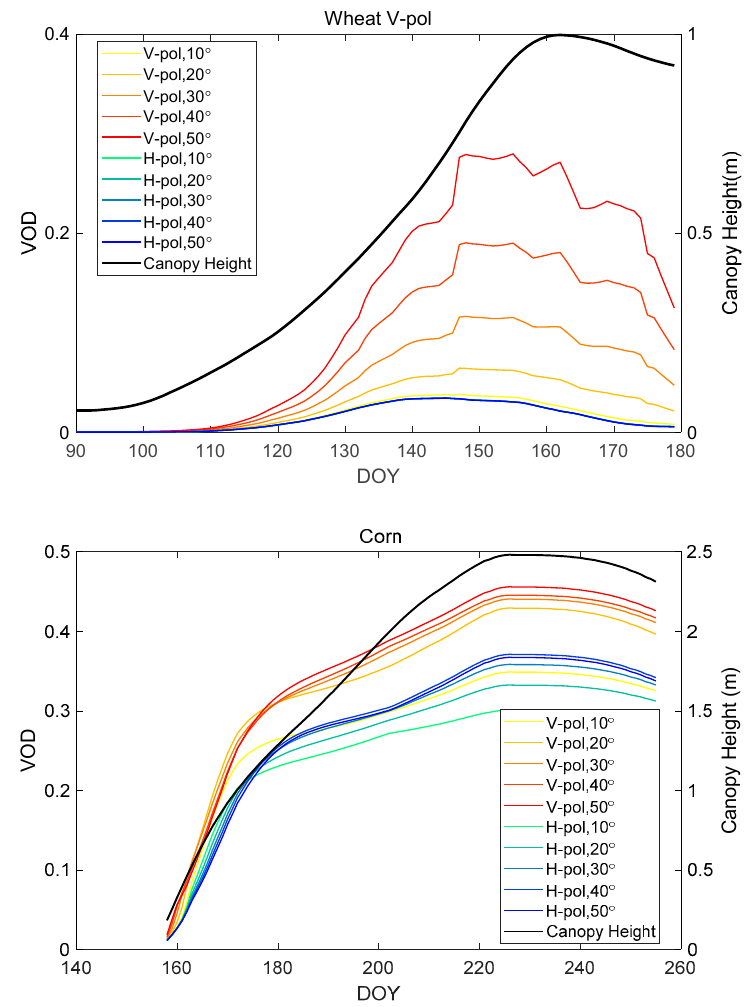
Figure 6. VOD S at V- and H-pol and several incident angles ( top : wheat, bottom : corn). To validate and explore the applicability of MVI to retrieve VOD, VOD T was calculated at the L-band and compared with VOD S , as shown in Figure 7. The correlation coefficients of VOD S and VOD T for corn and wheat were both as high as 0.99. But RMSE value of wheat figure was less than RMSE value of corn figure. The color bar shows the single leaf area of wheat and corn (cm 2 ). It is found that the retrieval accuracy decreases as leaf area increases, especially for corn. VOD T is underestimated comparing to VOD S for corn. It is believed that the assumption, the emissivity of vegetation was approximately equal at two adjacent incident angles, may introduce underestimation in VOD T retrieval.